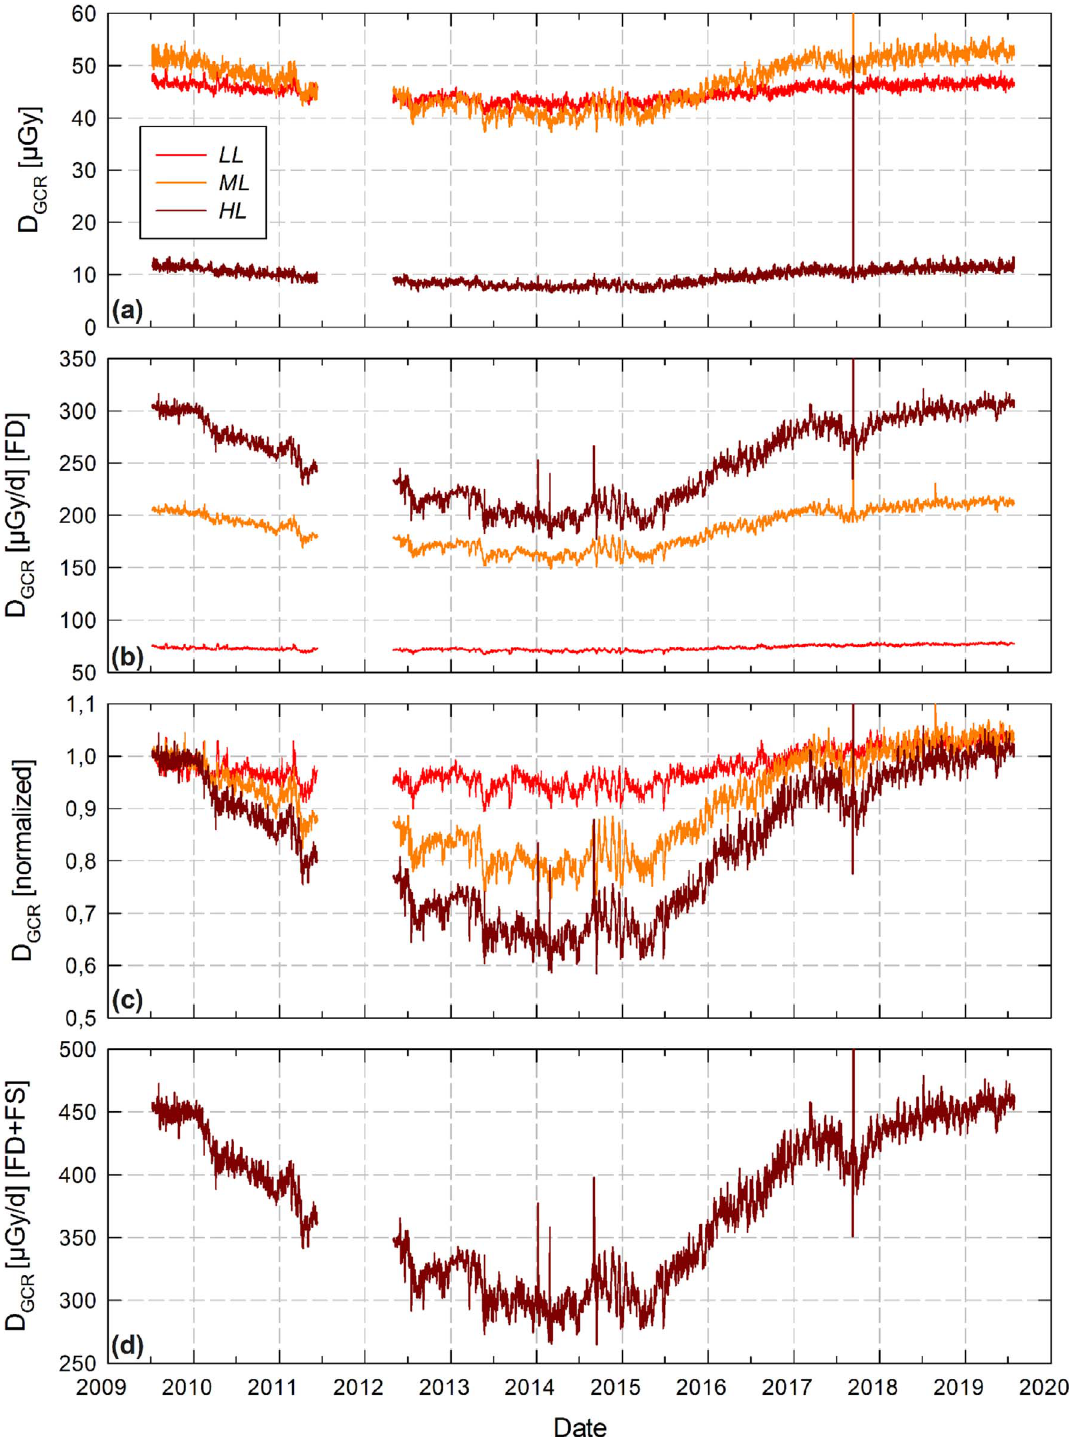
Fig. 9. (a) Daily GCR dose based on low, medium and high L -value cut; (b) GCR dose extrapolated to a full day (FD) occupancy of the ISS in the respective LL , ML and HL -value regimes; (c) normalized dose values as given in (b); and (d) daily GCR free space (FS) dose for an instrument with the relevant shielding as for the Columbus